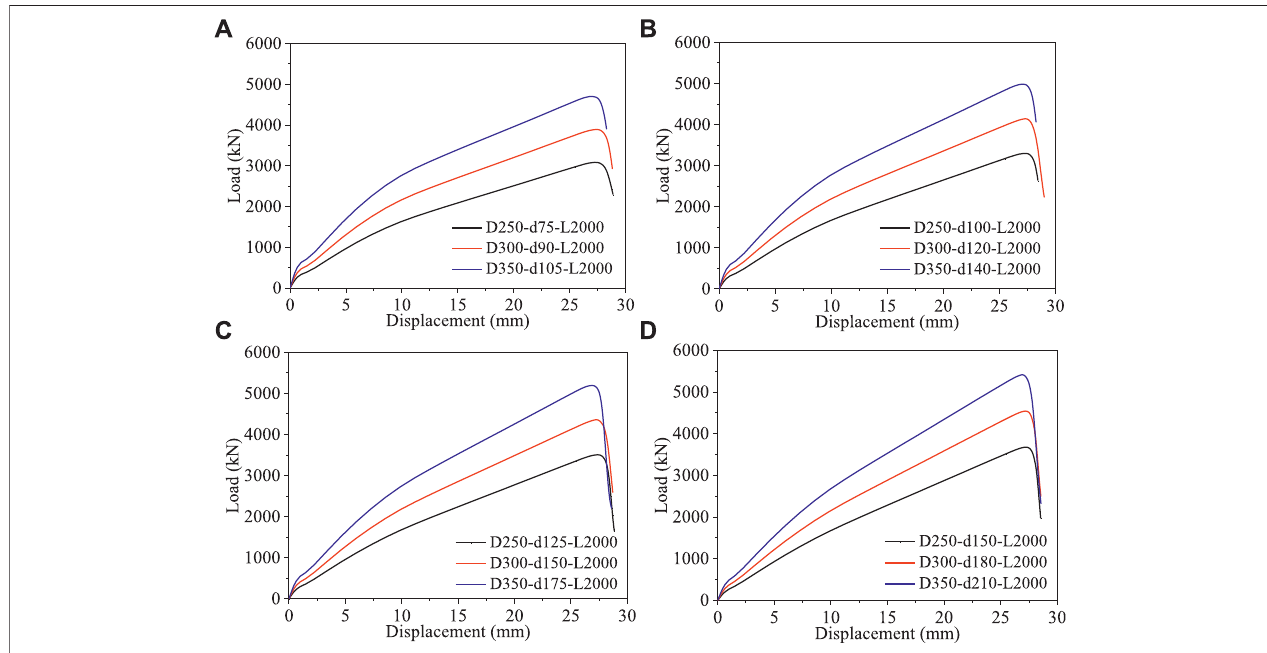
FIGURE 12 | In fl uence of the exterior diameter of outer tubes ( L = 2000 mm). (A) χ = 0.3. (B) χ = 0.4. (C) χ = 0.5. (D) χ =